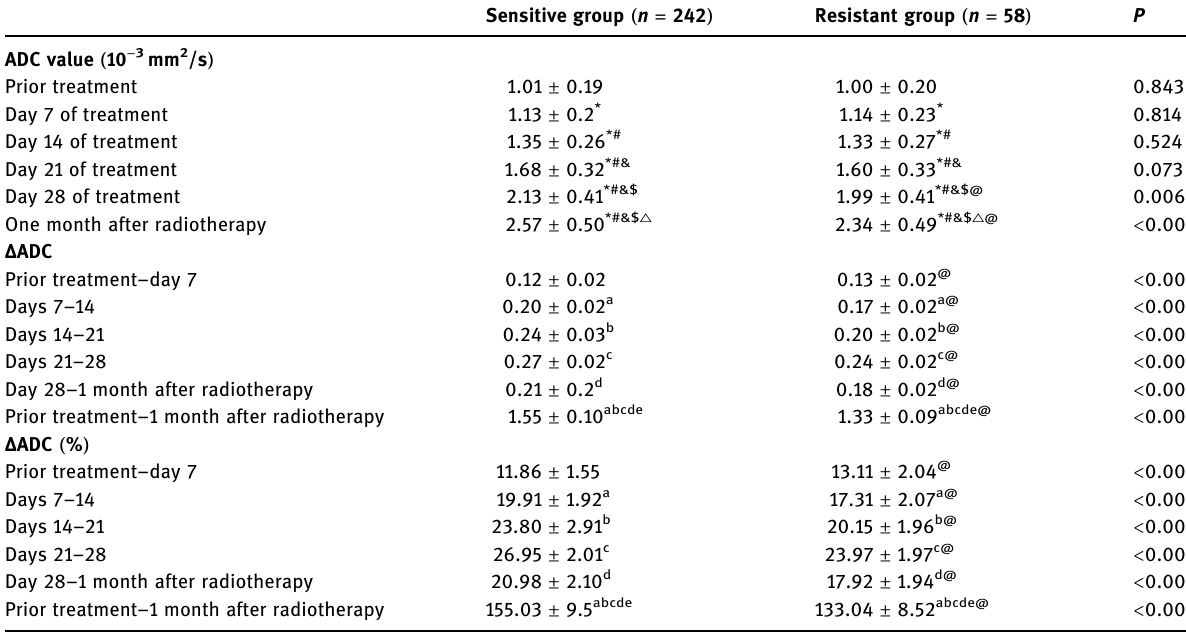
Table 2: Average ADC values and their rate of change at di ff erent time points ( mean ± standard deviation ) Sensitive group ( n = 242 ) Resistant group ( n = 58 ) ADC value ( 10 − 3 mm 2 /s